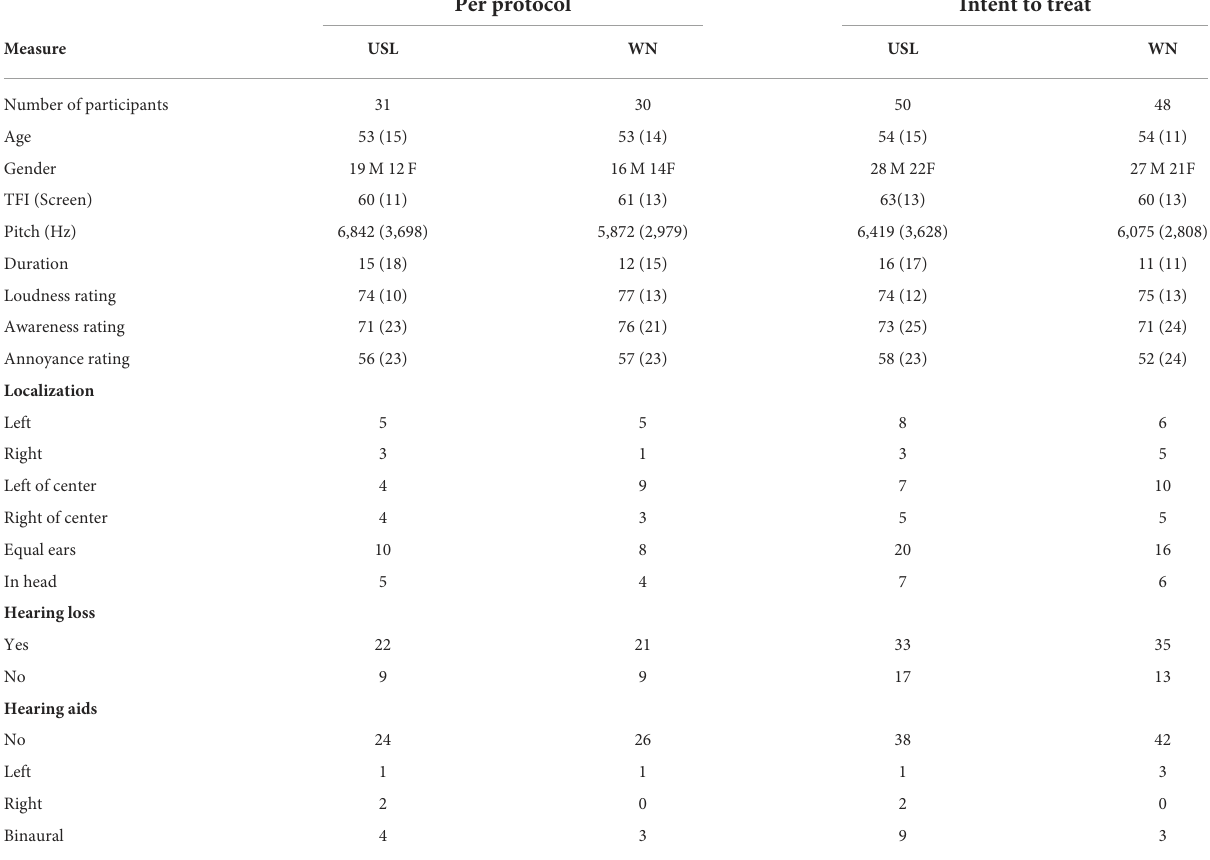
TABLE 1 Summary of participant